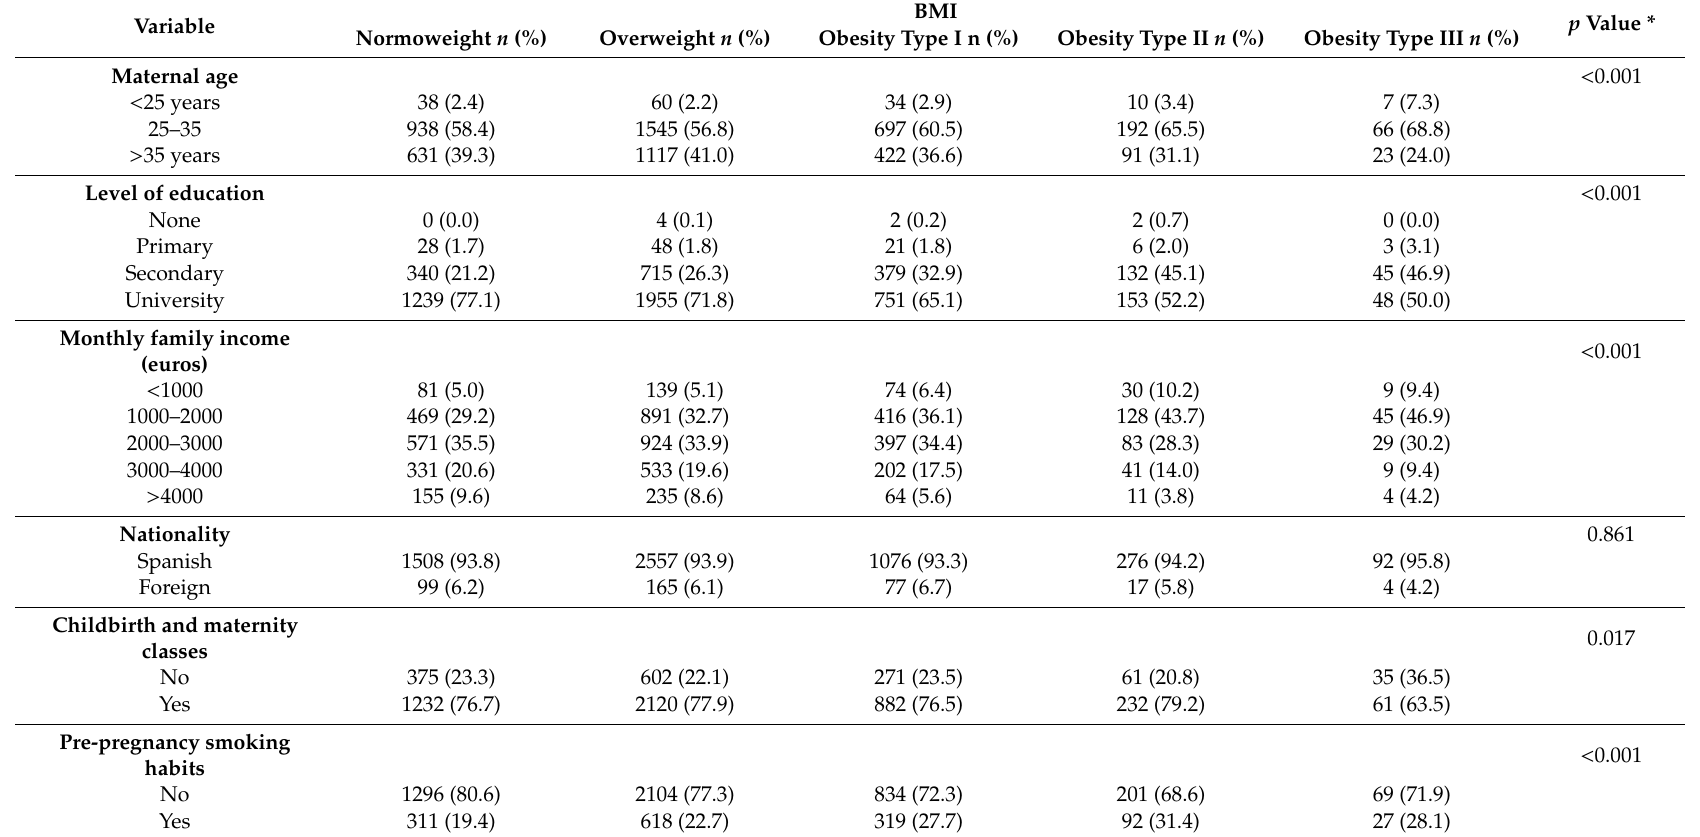
Table 1. Sociodemographic and obstetric characteristics of the women according to the body mass index